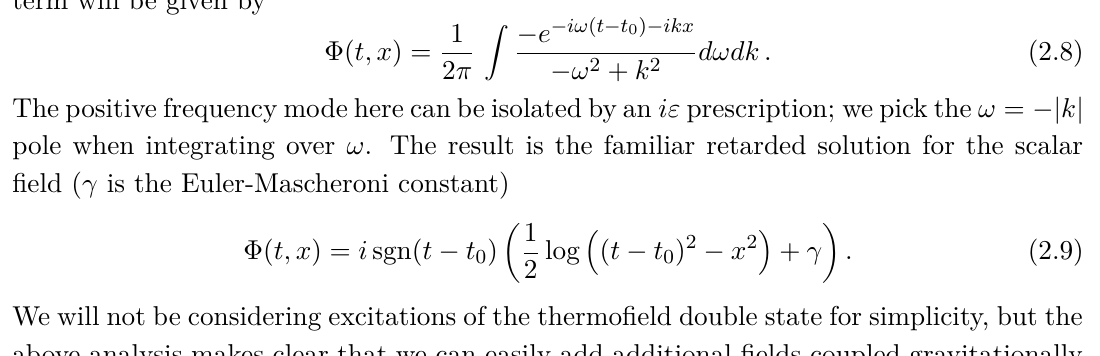
Figure 3 . The domains in the Lorentzian geometry dual to a single fundamental domain c M n . We have indicated both the ‘ket’ and ‘bra’ components of the spacetime M k and M b which are each a copy of the AdS geometry past of the Cauchy slice at t = 0 . The geometry c M 2 locus of the replica Z action at the splitting surface γ . The ket and bra geometries are real in the n Rindler wedges, regions spacelike separated from γ , but are complex in the Milne wedge, the causal past of γ